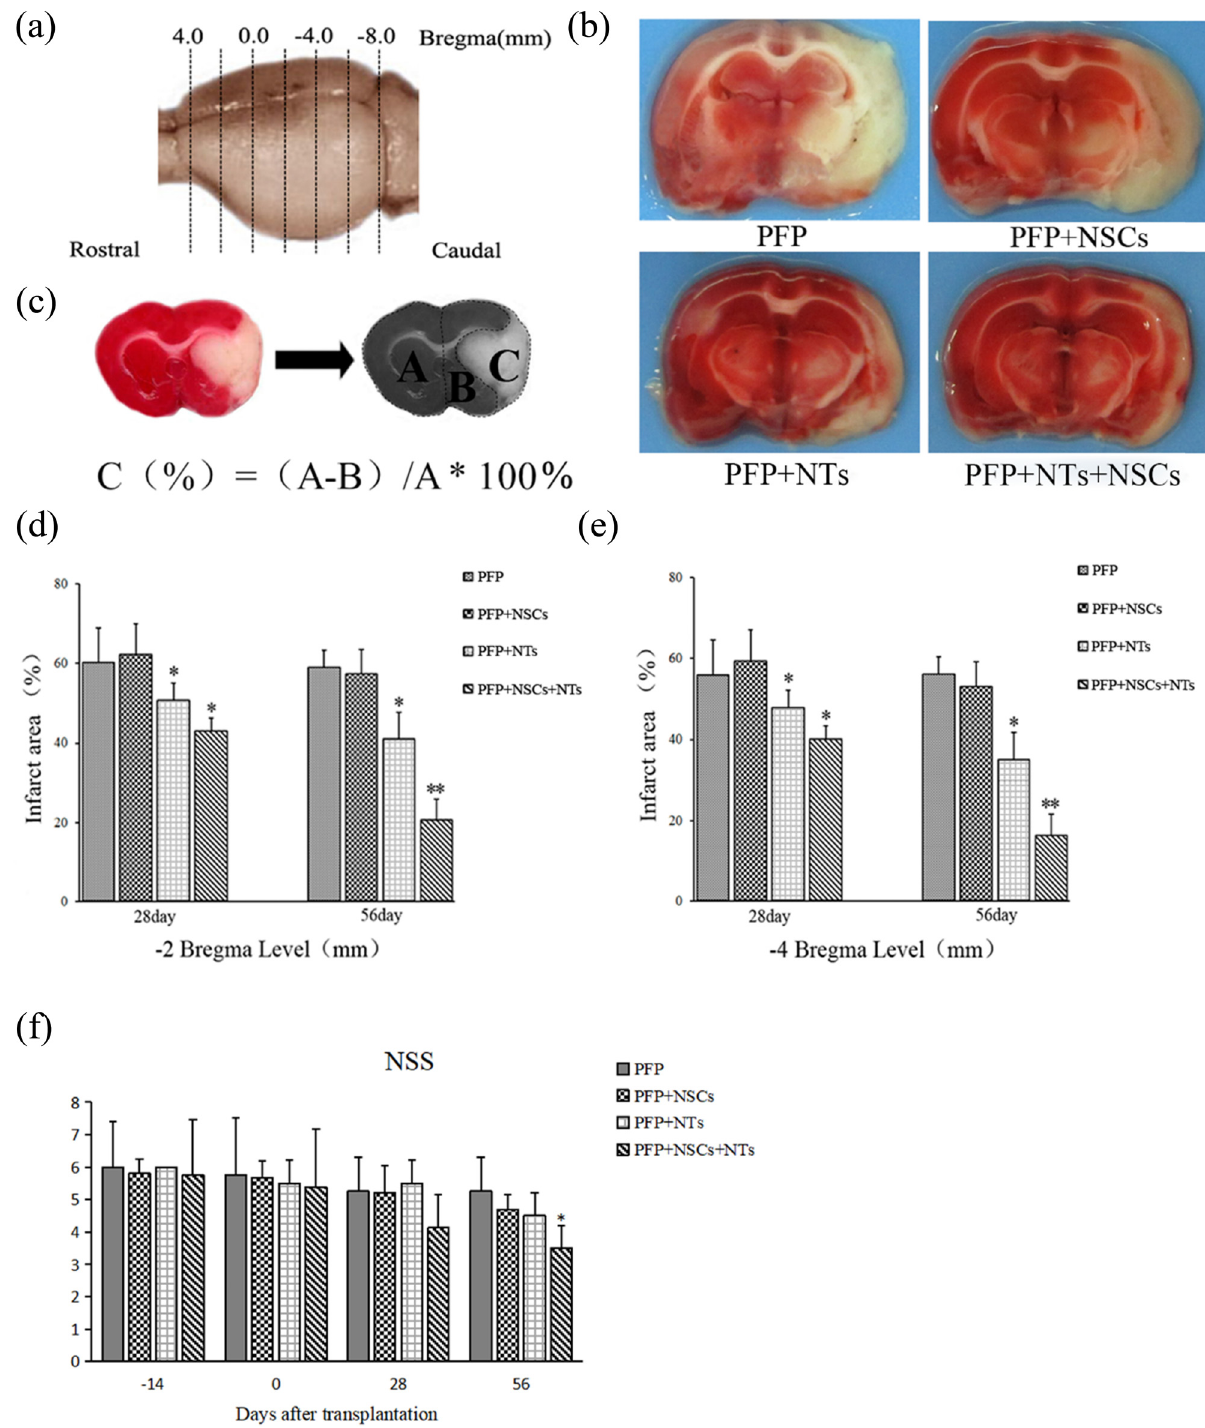
Figure 5: Transplantation of NSCs - polymer sca ff old reduced infarct size and improved behavioral performance. ( a ) Bregma as baseline, the brains were cut every 2 mm to stain by TTC. ( b ) The infarct size of brain slice at coordinate − 4 mm ( white ) was measured by TTC staining 56 days after transplantation. ( c ) The schematic diagram of infarct size calculation. ( d ) Measurement of the infarct size with coordinate − 2 mm level, 28 and 56 days after transplantation ( n = 3 ) . ( e ) Measurement of the infarct area at coordinate − 4 mm level, 28 and 56 days after transplantation ( n = 3 ) . ( f ) Behavioral performances were tested using NSSs ( n = 5 ) . The results are shown as the mean value ± SD ( * p < 0.05, ** p < 0.01 vs PFP group )